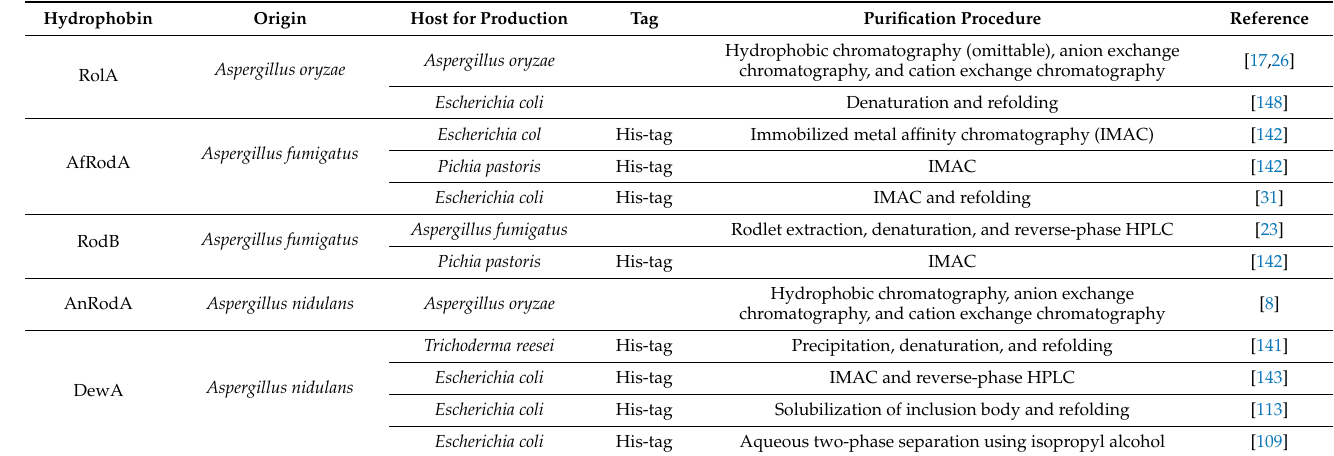
Table 3. Procedures for Aspergillus hydrophobin